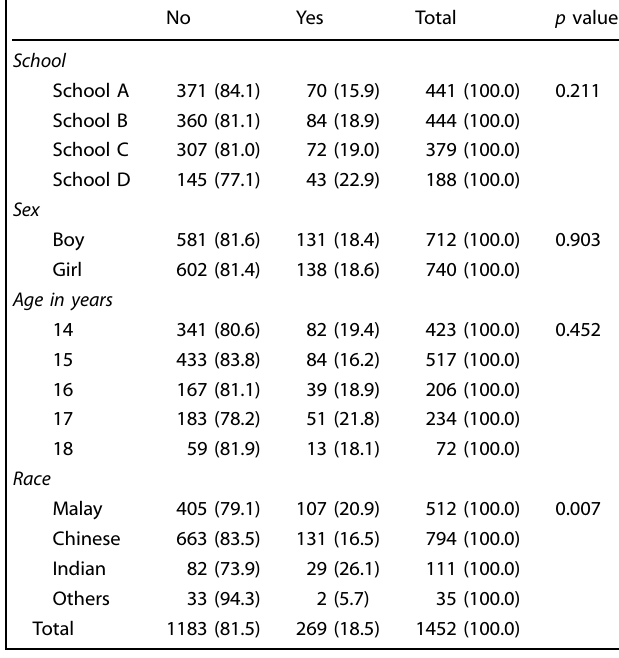
Table 1. Number (%) of students who reported pain in tooth in the past 1 month ( N = 1452).